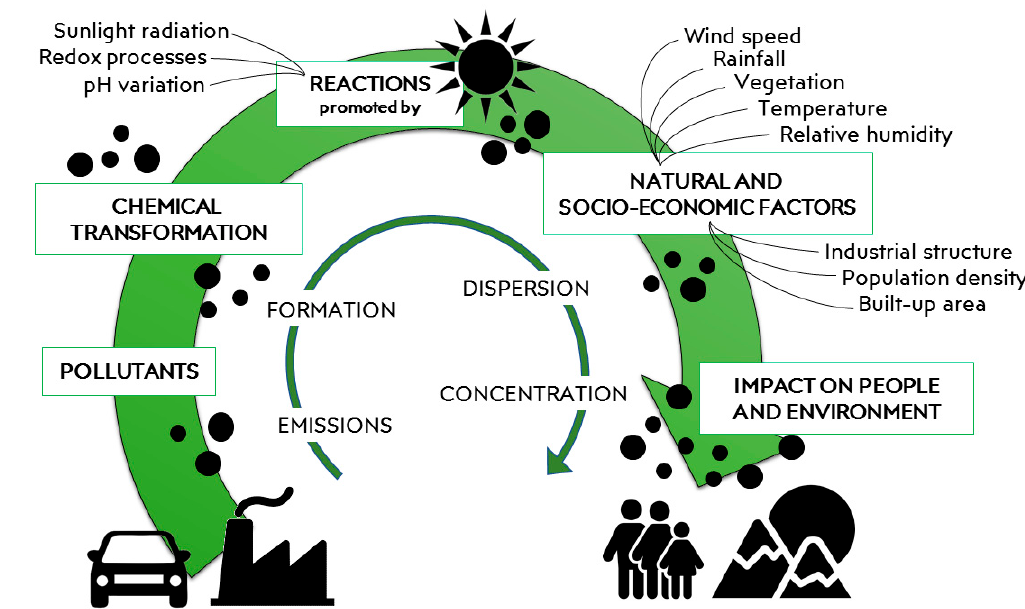
Figure 1. Cycle of pollution from the emission to the impact on people and environment.